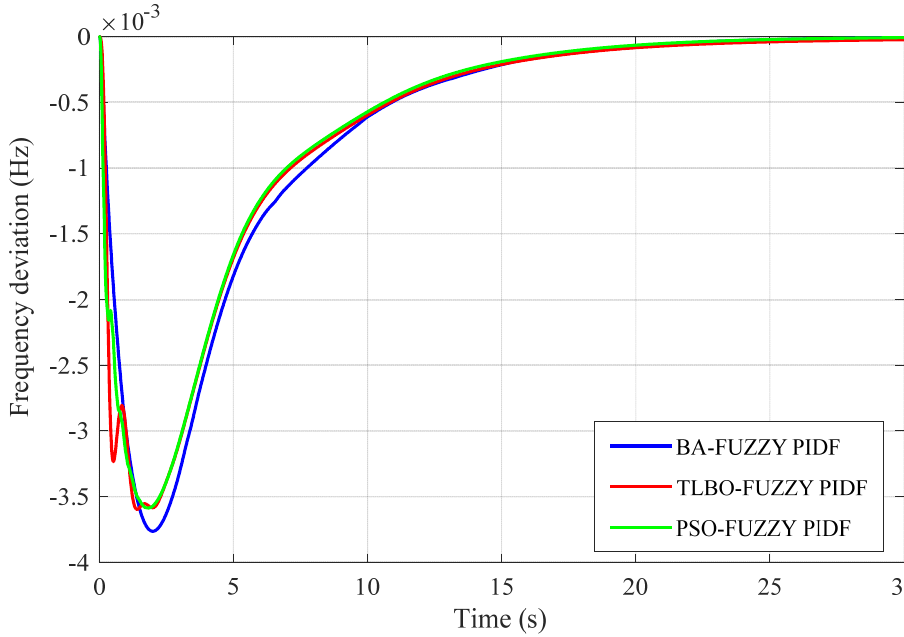
Figure 19. Frequency deviation in area 2 ( ∆ F 2 ).